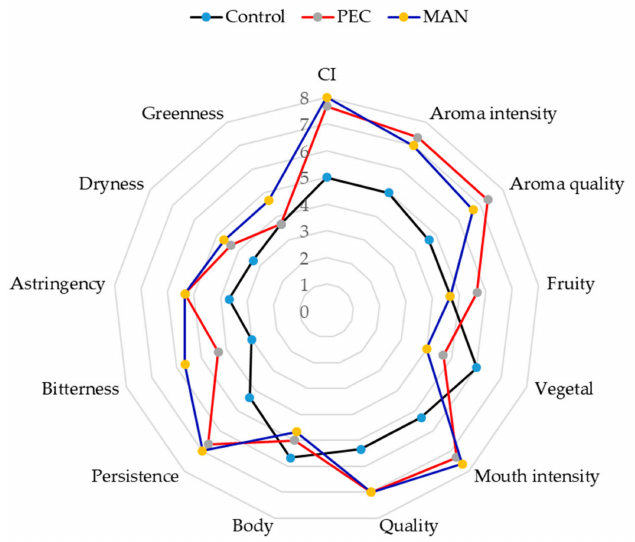
Figure 11. Results of the descriptive analysis performed by ten panelists for wines after six months in the